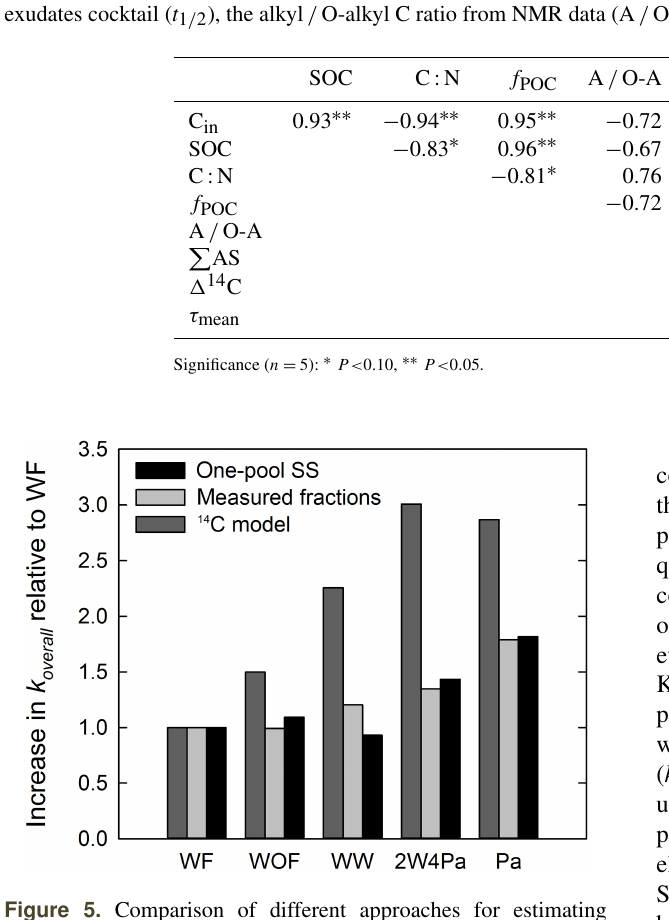
Figure 5. Comparison of different approaches for estimating changes in carbon cycling rates. Increases in k overall relative to the WF treatment is given for a simple one-pool steady-state (SS) calcu- lation ( k = C in / SOC), the predicted k based on measured fractions assuming k pool = 0.33, 0.02 and 0.001yr − 1 in the POC, HOC and ROC fraction, respectively, and the mean k overall value from mod- eling the incorporation of 14 C into the soil (scenario